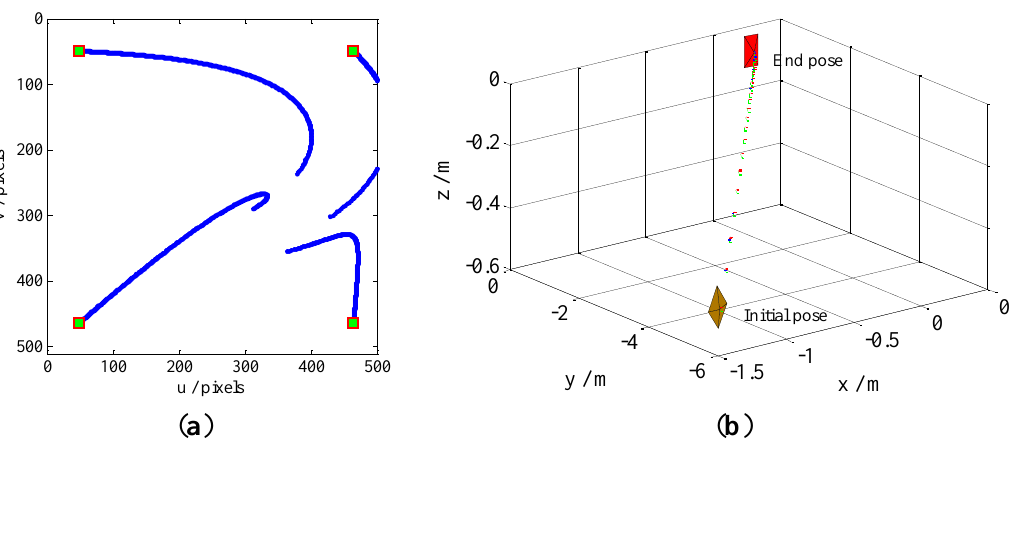
= v = 256 and fk = fk = 1,000. The camera trajectory 0 0 u v